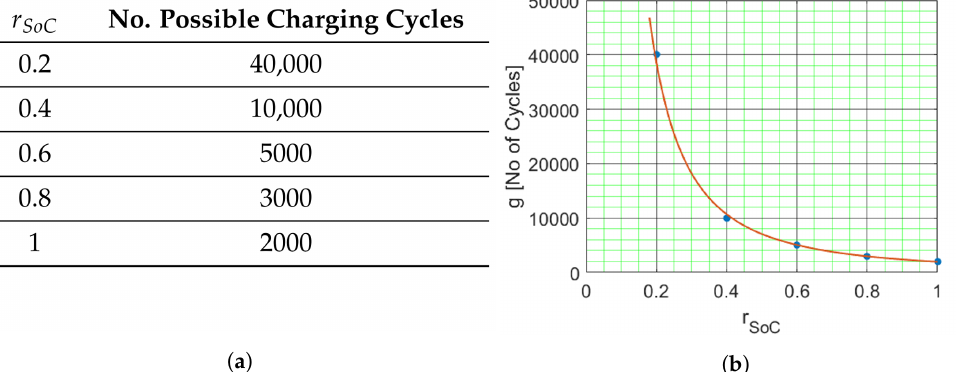
Figure 2. ( a ) The number of possible charging cycles for a modern lithium battery depending on the parameter r SoC . ( b ) A power function g ( r SoC ) is fitted to the table values and is indicated with blue